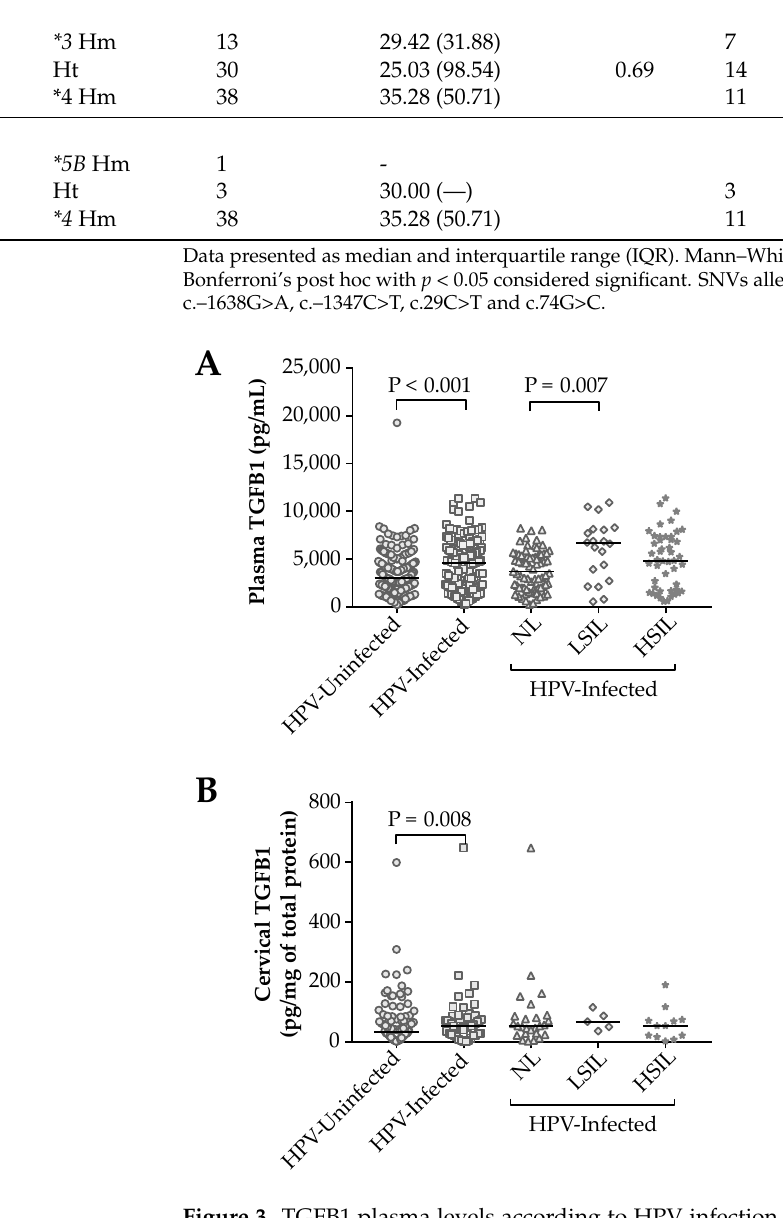
Figure 3. TGFB1 plasma levels according to HPV infection and lesion grade ( A ). TGFB1 levels in cervical mucus according to HPV infection and lesion grade ( B ). Differences between groups were assessed by Mann–Whitney test or Kruskal–Wallis test with Dunn–Bonferroni’s post hoc. p < 0.05 considered significant. Table 3. Comparison of the frequency of TGFB1 haplotypes in HPV and cervical lesion groups .